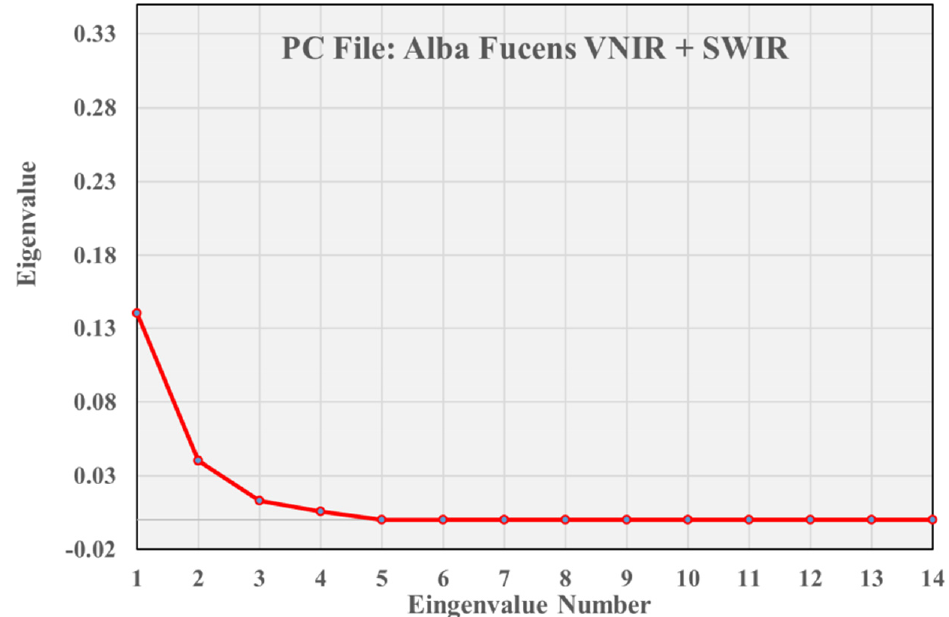
Figure 9. Alba Fucens: PCA (eigenvalues) in the VNIR dataset; the PCA plot shows that the information is concentrated in the first four components, in particular the highest values are found in PC ‐ 1, PC ‐ 2 and PC ‐ 3.